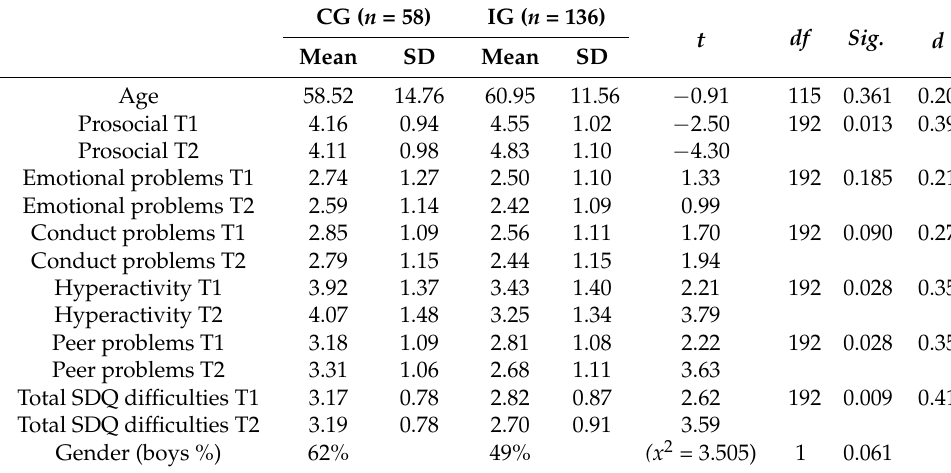
Table 1. Descriptive statistics and t -test results of